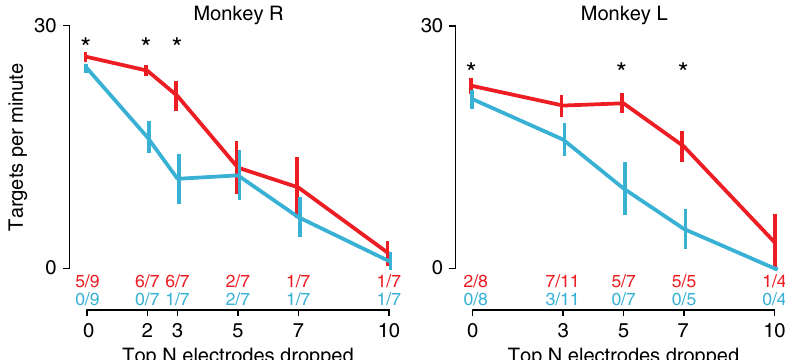
Figure 3 | Robustness to unexpected loss of the most important electrodes. Closed-loop BMI performance using the MRNN (red) and FIT Sameday (blue) decoders while simulating an unexpected loss of up to 10 electrodes by setting the firing rates of these electrodes to zero. The mean and s.e.m. across experimental sessions’ targets per minute performance is shown for each decoder as a function of how many electrodes were removed. Stars denote conditions for which the MRNN significantly outperformed FIT Sameday across sessions ( P o 0.05, paired t -test). The text above each condition’s horizontal axis tick specifies for how many of the individual evaluation days MRNN (red fraction) or FIT Sameday (blue fraction) performed significantly better than the other decoder according to single-session metrics of success rate and time to target. Electrode-dropping order was determined by the mutual information between that electrode’s spike count and target direction during arm-controlled